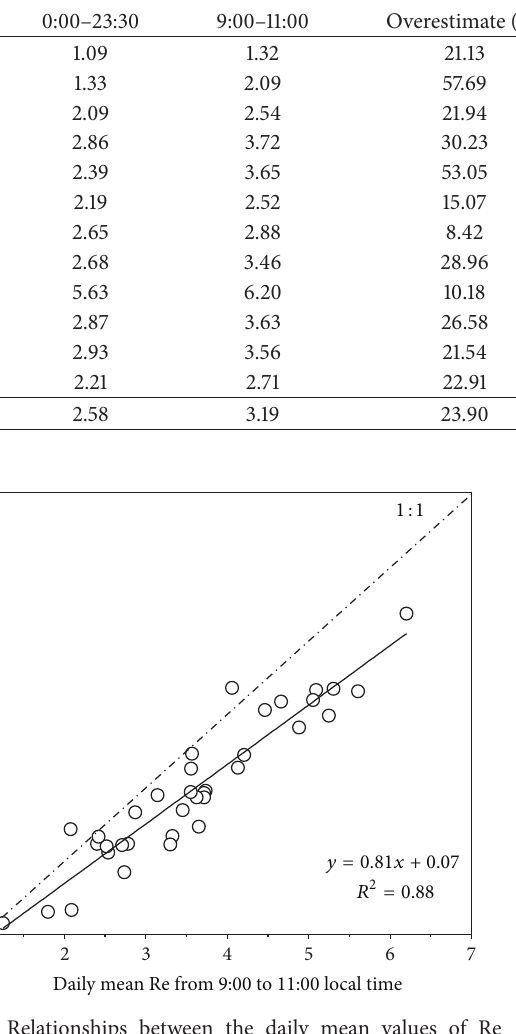
Figure 2: Relationships between the daily mean values of Re ( 𝜇 moLm −2 s −1 ) calculated from 0:00–23:00 h local time and the Re estimated by 9:00–11:00 h a.m. local time; all the measurements for three chambers for all the sampling dates were pooled together, 𝑛 = 36